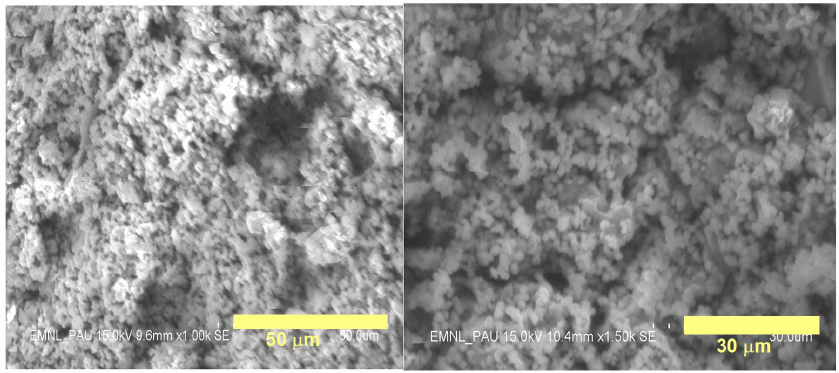
Figure 12. FE SEM images of functionalized organic-inorganic nano composites (11) .